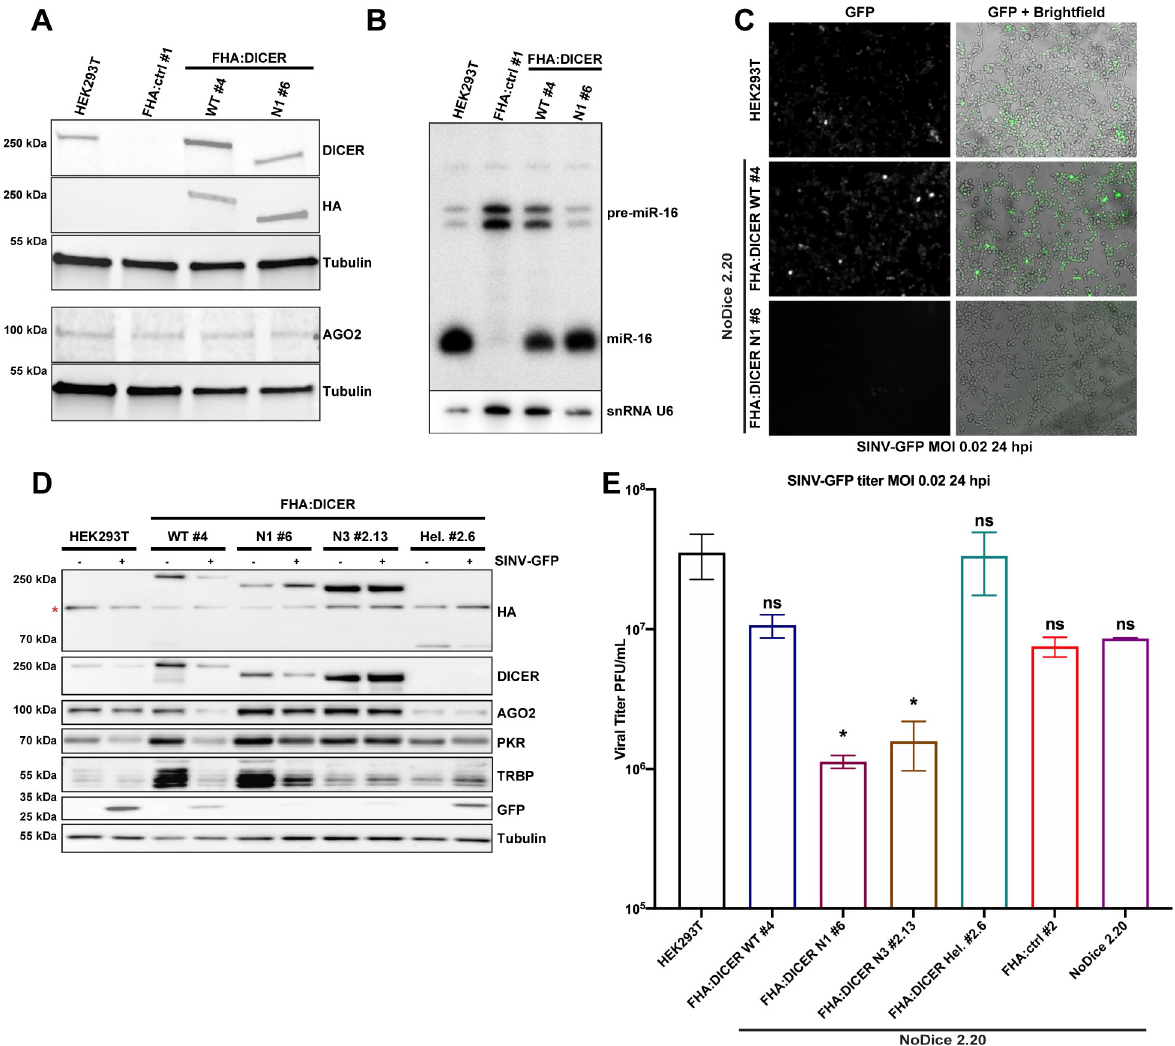
Fig 6. Analysis of the importance of Dicer helicase domain on SINV-GFP infection in FHA:DICER mutant stable cell lines. A. Expression of DICER (DICER, HA), TRBP and AGO2 was analysed by western blot in HEK293T, NoDice FHA:ctrl #1, FHA:DICER WT #4 and FHA:DICER N1 #6 cell lines. Gamma-Tubulin was used as loading control. B. Northern blot analysis of miR-16 expression in the same samples as in A. Expression of snRNA U6 was used as loading control. C. Representative GFP fluorescent microscopy images of HEK293T, FHA:DICER WT #4 and FHA: DICER N1 #6 cell lines infected with SINV-GFP at an MOI of 0.02 for 24 h. The left panel corresponds to GFP signal and the right panel to a merge picture of GFP signal and brightfield. Pictures were taken with a 5x magnification. hpi: hours post-infection. D. Western blot analysis of DICER (DICER and HA), AGO2, PKR, and GFP expression in SINV-GFP-infected cells in the same condition as in C. Gamma-Tubulin was used as loading control. The asterisk correspond to aspecific bands E. Mean (+/- SEM) of SINV-GFP viral titers fold change over HEK293T cells in HEK293T, NoDice 2.20, FHA:DICER WT #4 and FHA:DICER mutants cell lines infected at an MOI of 0.02 for 24 h (n = 3) from plaque assay quantification. � p < 0.05, ns: non-significant, ordinary one-way ANOVA test with Bonferroni